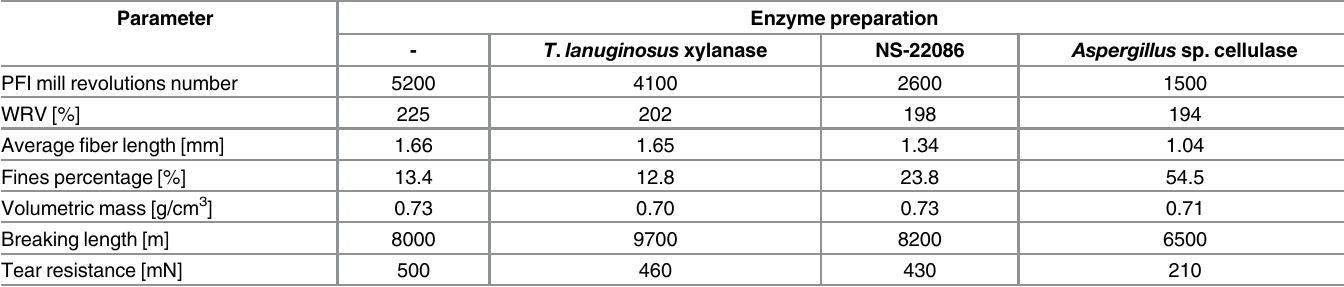
Table 4. The impact of the three enzyme preparations on refined pulp and paper parameters (for pulp freeness of 30°SR). Parameter Enzyme